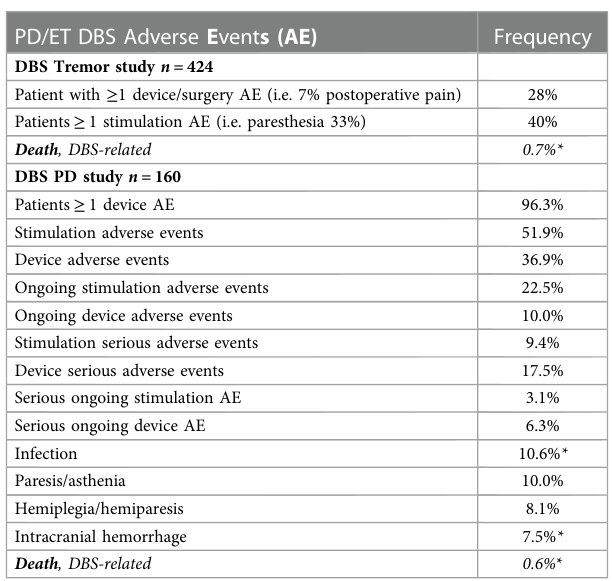
TABLE 1 Bene fi cence/non male fi cence deep brain